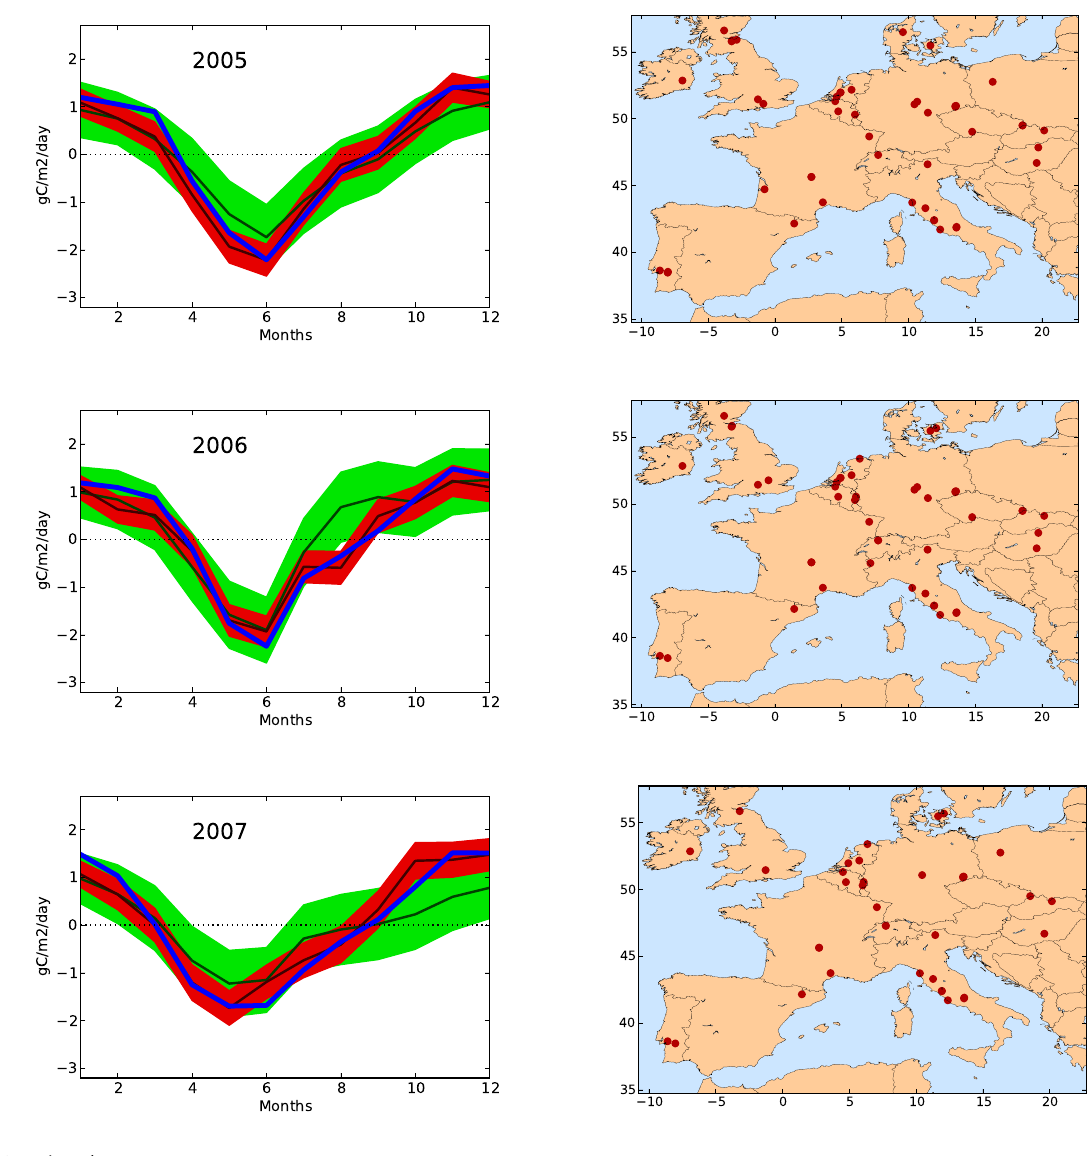
Fig. 2. Fig. 2. Temporal evolution of monthly (i.e. 30-day mean) NEE ( g C m CE-L4 locations specified for a full year in the maps. Blue: CE-L4 data averages; green: ORCHIDEE; red: inverted fluxes; shaded areas: NEE ± standard deviation of the uncertainty in NEE. 26